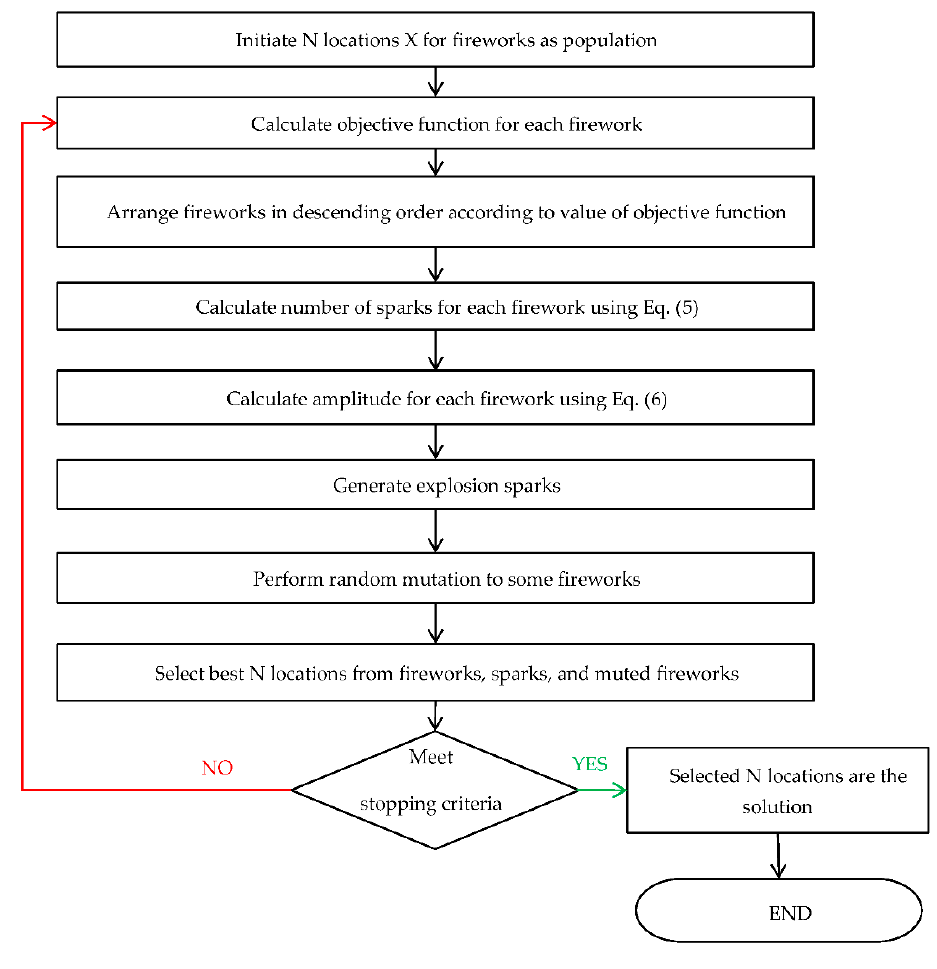
Figure 3. Flowchart of Fireworks Algorithm (FWA).